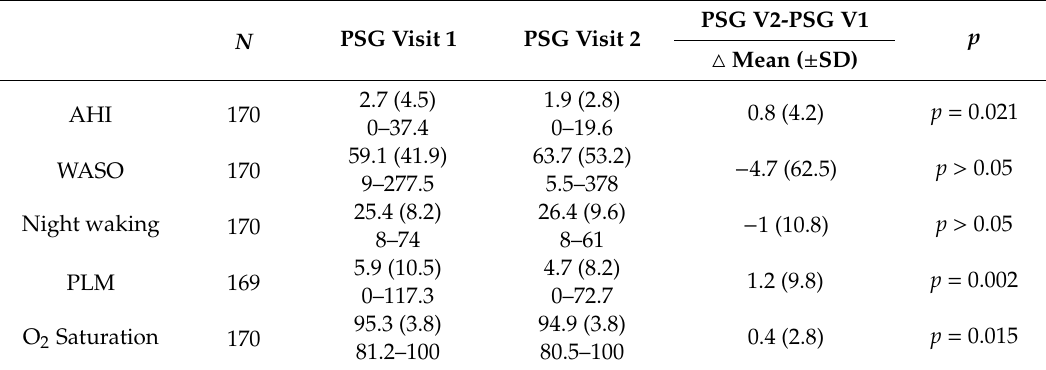
Table 3. Mean ( ± SD) and range for PSG Scores at visit 1 and